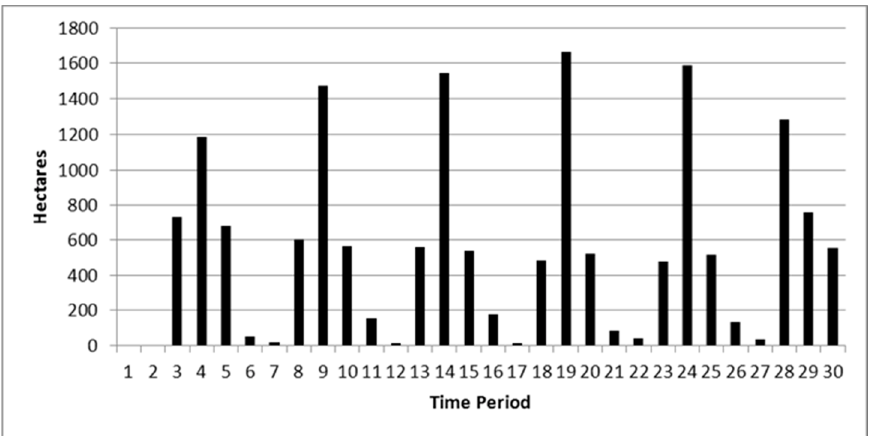
Figure 6. Area of Kirtland’s warbler habitat regeneration by time period in the S3 2226 scenario. The cyclical pattern largely corresponds with the large amount of similarly aged habitat currently on the landscape that does not need to be replaced for several time periods.